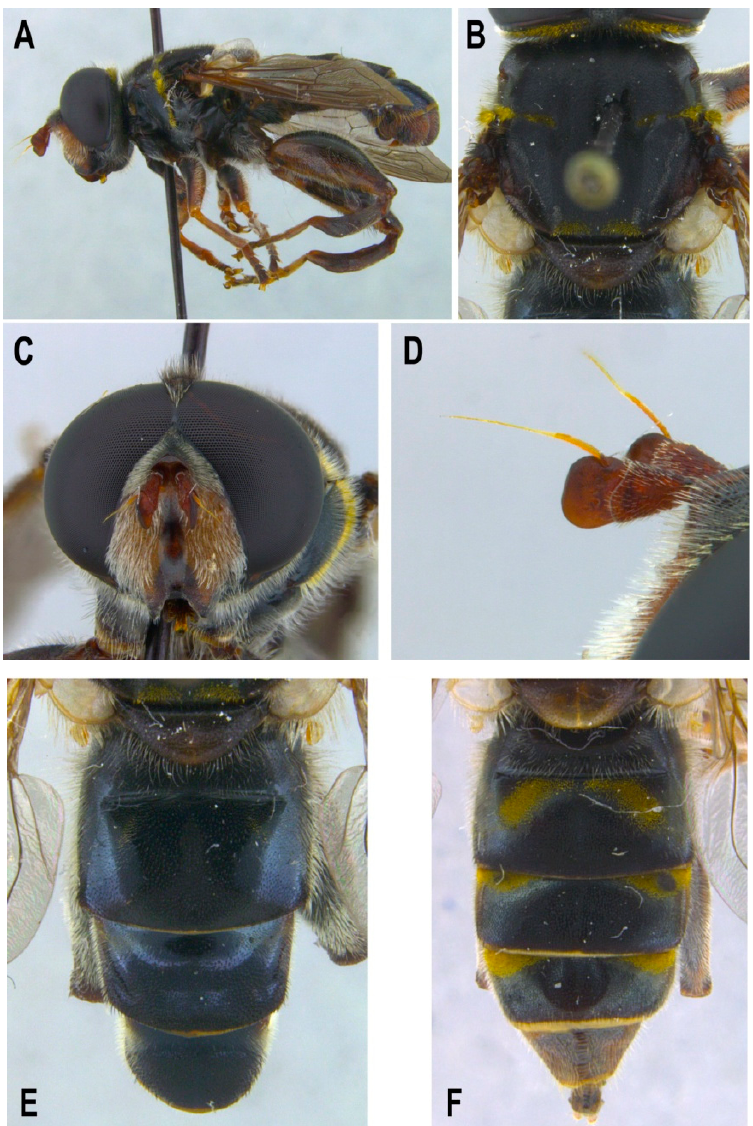
Figure 1. Meromacrus cactorum sp. nov., adult ( A – E ): male holotype. f: female paratype). ( A ): entire body, lateral view. ( B ): thorax, dorsal view. ( C ): head, anterior view. ( D ): antennae, lateral view. ( E , F ): abdomen, dorsal view.